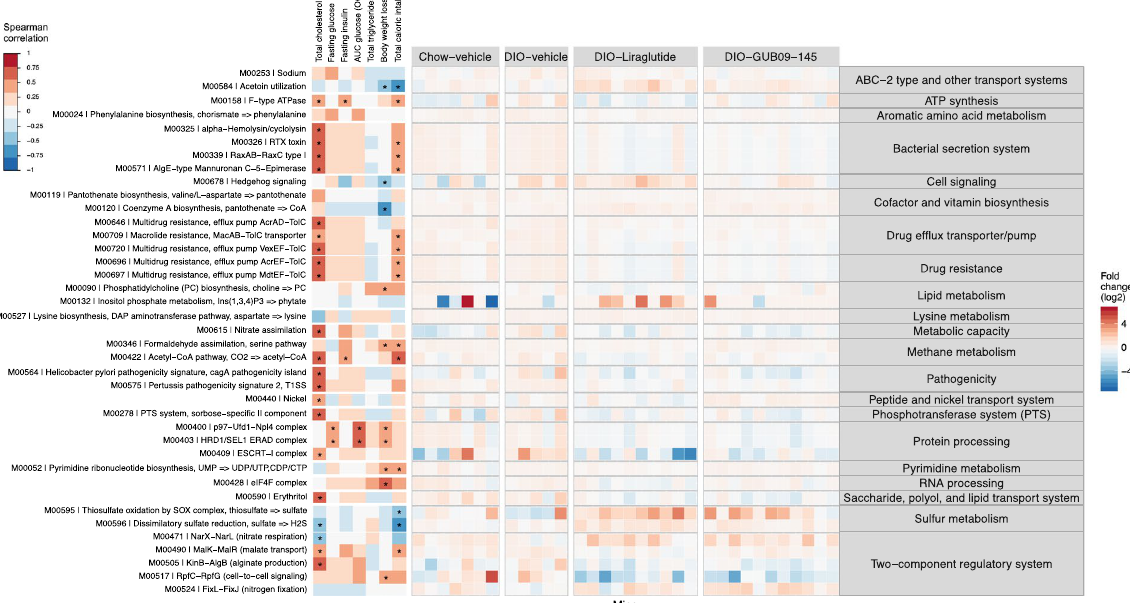
Figure 6. Bacterial KEGG metabolic pathways affected by treatment with liraglutide and GUB09-145. Heatmap depicting bacterial KEGG modules with changes over the course of liraglutide and GUB09-145 treatment. Left heatmap : Spearman correlations between change in individual species abundance and various metabolic parameters affected by treatment, including plasma total cholesterol (TC), fasting glucose level on treatment day 14 (Fasting glucose), fasting terminal insulin levels (fasting insulin), glucose area-under the curve in an oral glucose tolerance test on treatment day 27 (AUC glucose OGTT), terminal plasma total triglycerides (TG), endpoint body weight loss relative to baseline (Body weight loss), and total caloric intake during the treatment period (Total caloric intake). Asterisks denote significant correlation (FDR-corrected, p < 0.05) between species and relevant metabolic parameter. Right heatmap : Fold change (log 2 transformed) in species abundance in individual mice as compared to